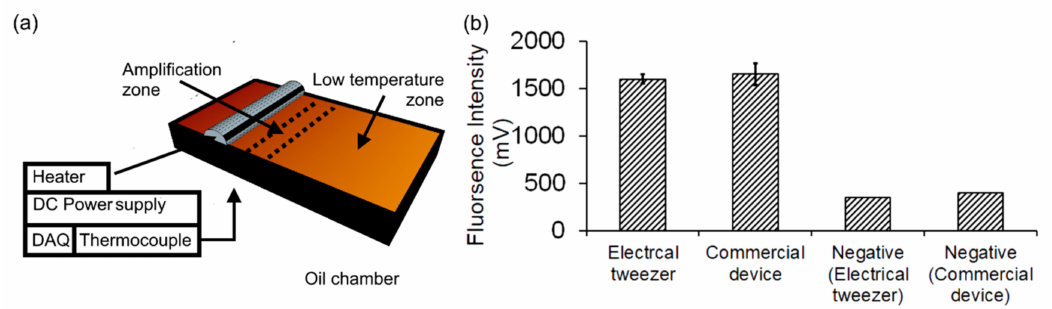
Figure 7. Loop-mediated isothermal amplification of DNA by electrical tweezers: ( a ) Schematics of bi-layer oil chamber for DNA amplification; ( b ) comparison of end- point fluorescence intensity of positive samples by electrical tweezers and fluorescence reader (ESE-Quant Tube scanner) with the negative control at ~65 ◦